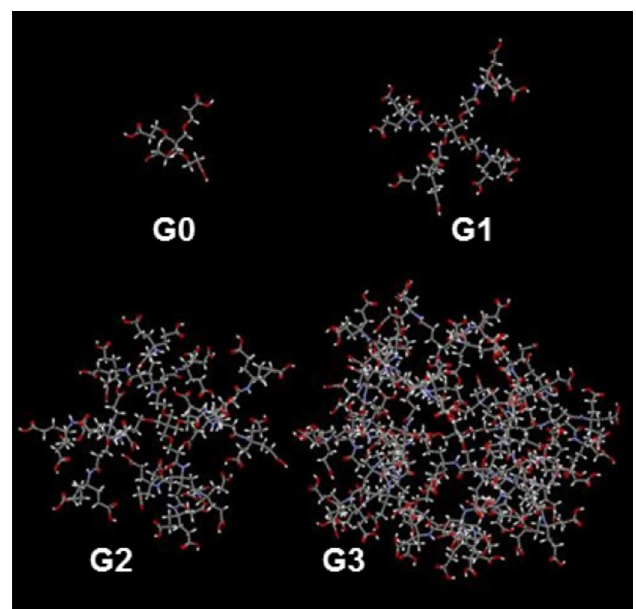
FIGURE 1 - Computer generated images of generations 0 through 3 of a 1 → 3 C -branched,